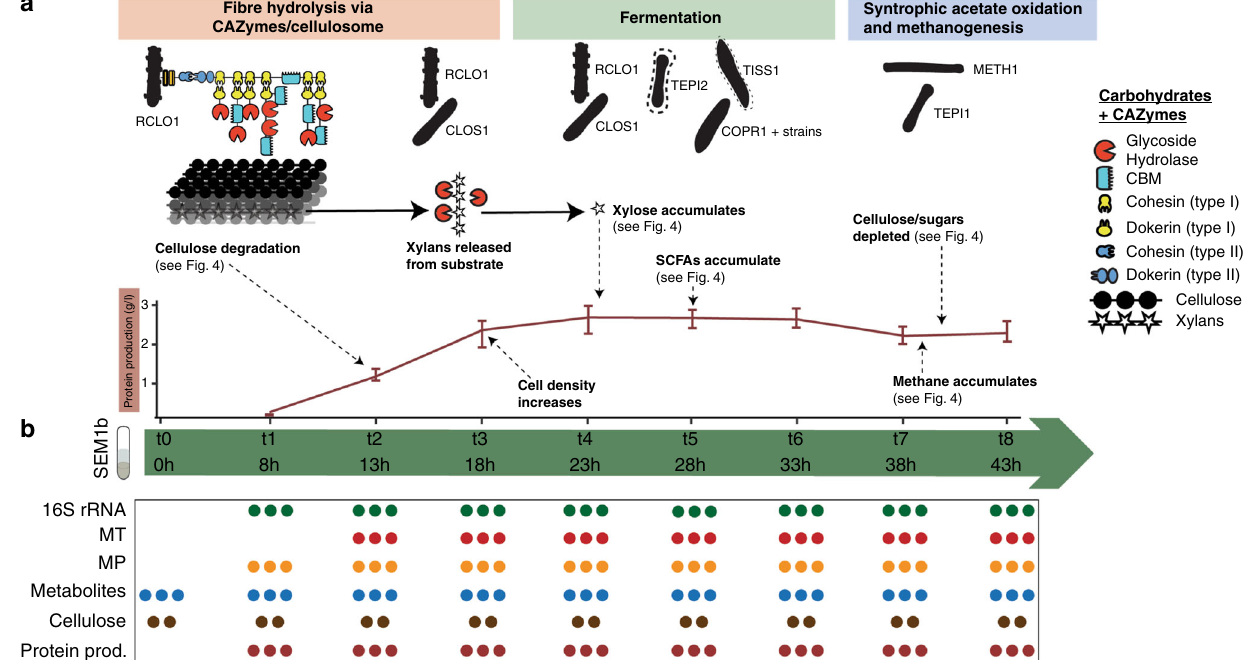
Fig. 1 Life cycle of the SEM1b consortium and sampling scheme. a In the SEM1b consortium, seven major microbial populations perform the metabolic processes that lead from sacchari fi cation to methanogenesis. In the fi rst phase, RCLO1 and CLOS1 degrade the spruce substrate (predominantly cellulose and hemicellulose), thanks to a sophisticated and fl exible enzymatic array, which releases simple oligosaccharides and sugars. Subsequently, the consortium grows (the protein concentration in the samples increases) up to t4 (23 h post inoculum), alongside the degradation (and fermentation) of mono- and disaccharides by RCLO1, CLOS1, TEPI1, TISS1, and COPR1 + strains. One of the sugars released from the degradation of xylan, xylose, is brie fl y accumulated (Fig. 4a). In addition, SCFAs are accumulated as a byproduct of microbial fermentation. In the last step, the synergetic partnership between TEP1 and METH1 (syntrophic acetate oxidizer and methanogen, respectively) converts the SCFAs and H 2 to methane. The bars in the protein pro fi le represent the maxima and minima of the measurements. b To characterize SEM1b, 24 fl asks containing spruce media were inoculated with a SEM1b culture at t0. Starting from t1 (8 h), three fl asks were opened every 5 h and their content processed. From the eight time points (plus t0) different omic- and meta- data were collected (depicted in the table). Every dot represents a replicate sample, and most measurements are taken in triplicate (except for cellulose